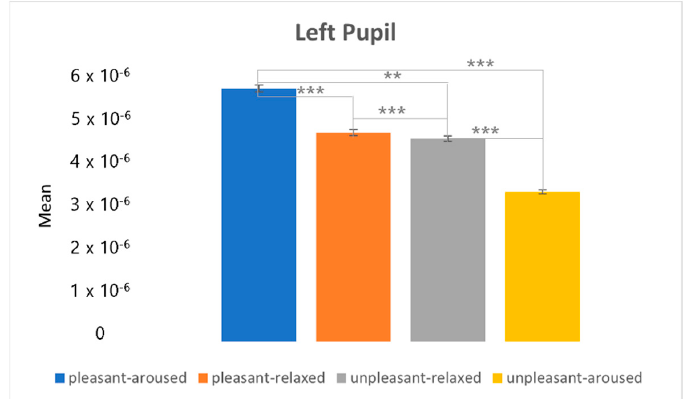
Figure 22. The post hoc analysis of the left pupil. ** p < 0.05. *** p < 0.001.